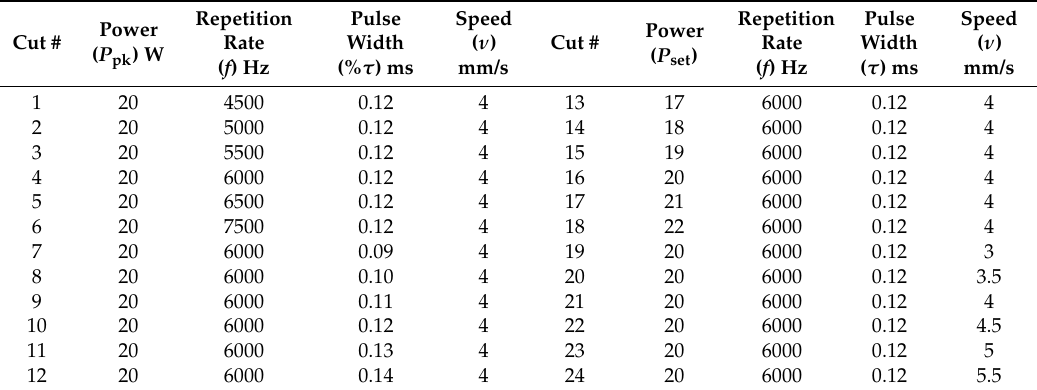
Table 2. Process parameters for Set A.